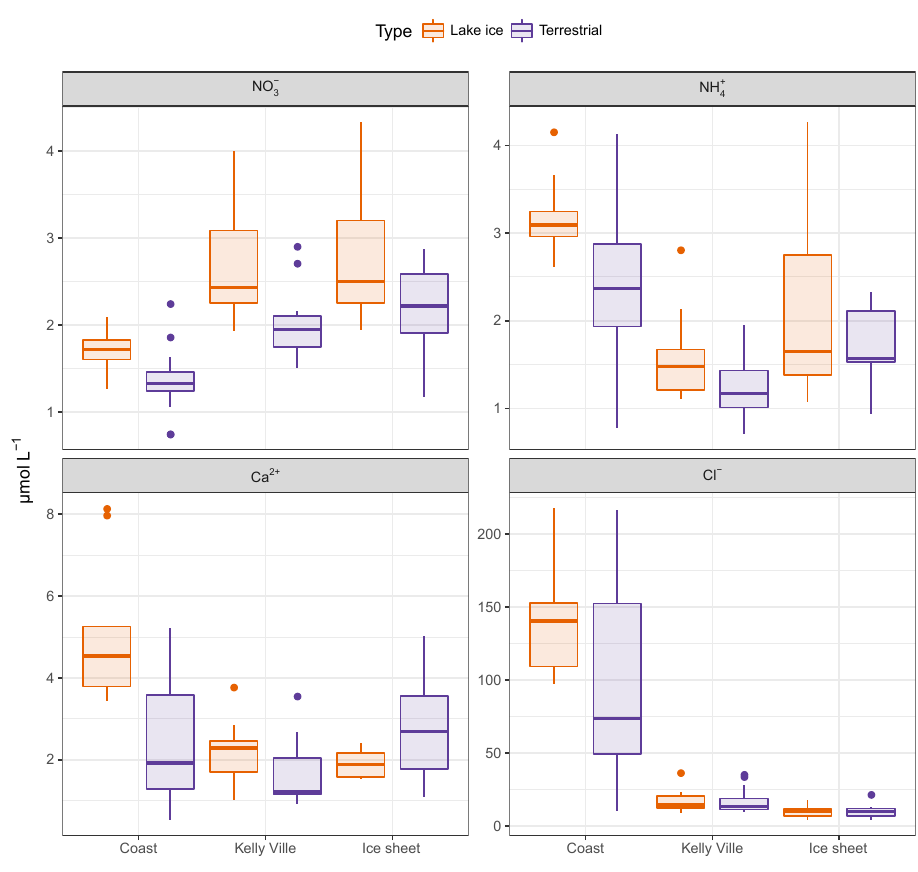
Figure 4. Comparison of lake ice and terrestrial snowpack concentrations (µmolL − 1 ) for selected ions. See Fig. 3 caption for explanation of box